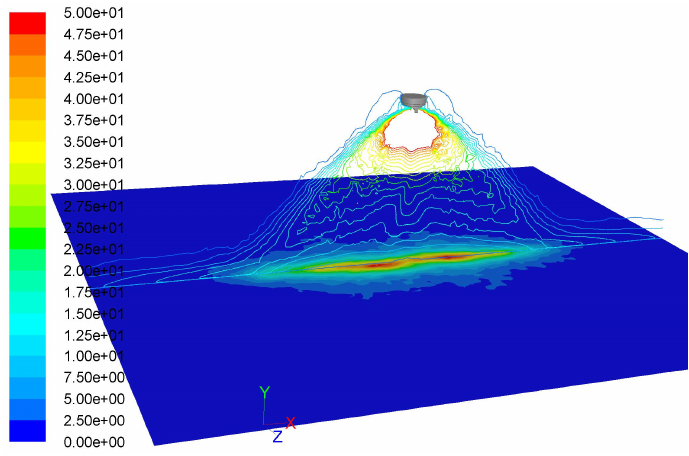
Figure 7. Calculated velocity contours colored by velocity magnitude (m/s) in the plane z = 0 (shaping air flow rate: 360 L/min). The static film thickness distribution on the plate is also overlaid.